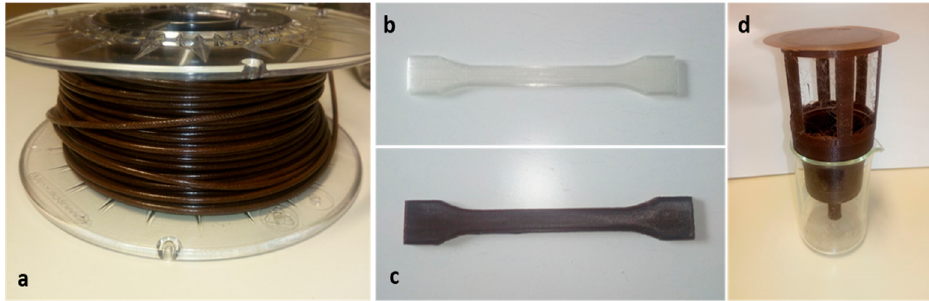
Figure 4. 3D printing filament composite produced with PLA + PPW ( a ), 3D printing tensile specimens ( b , c ), smart irrigation system ( d ).